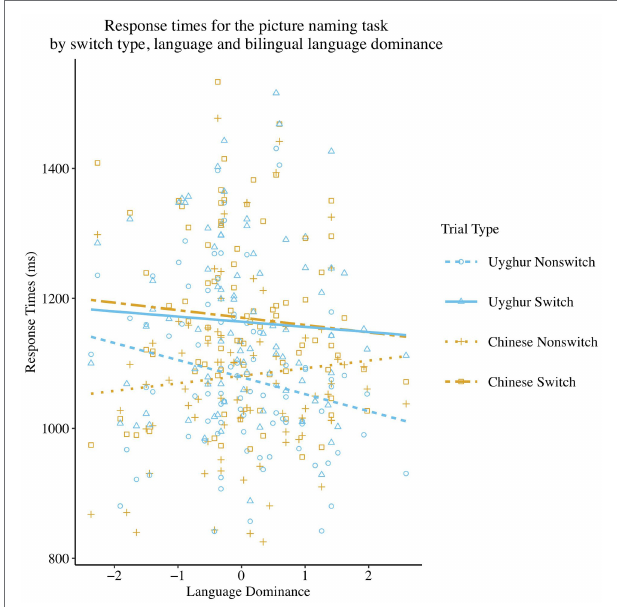
FIGURE 2 | Scatterplot and regression fit lines showing the correlation between Language Dominance and mean response times at each level of the combinations of Switch Type and Language in the picture naming task.